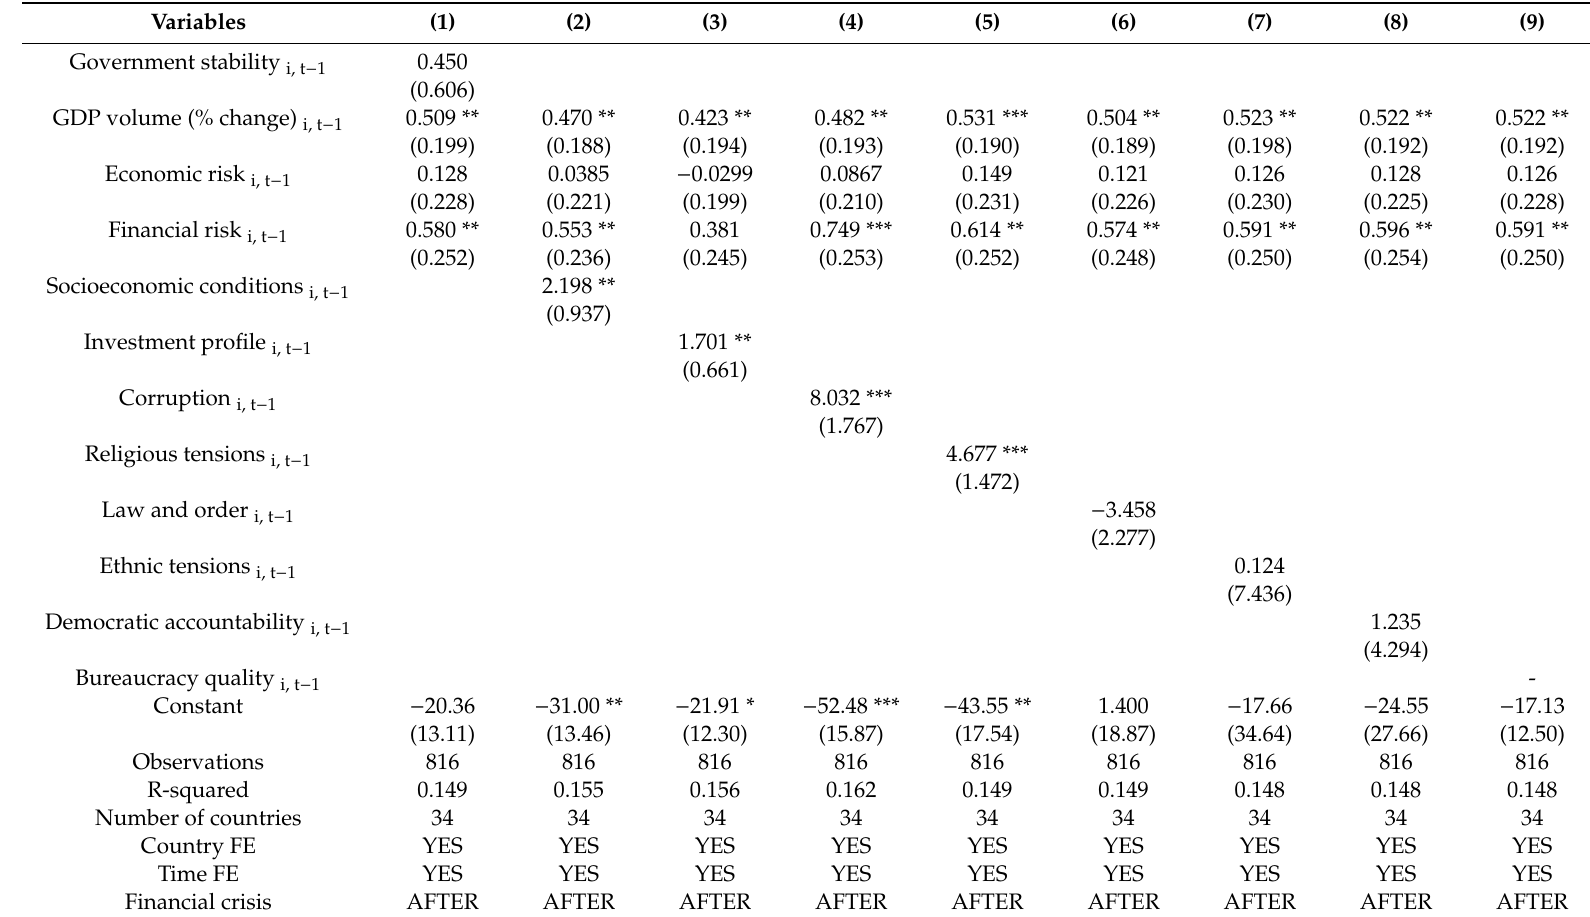
Table A8. Estimation results for OECD countries—components of political stability (after financial